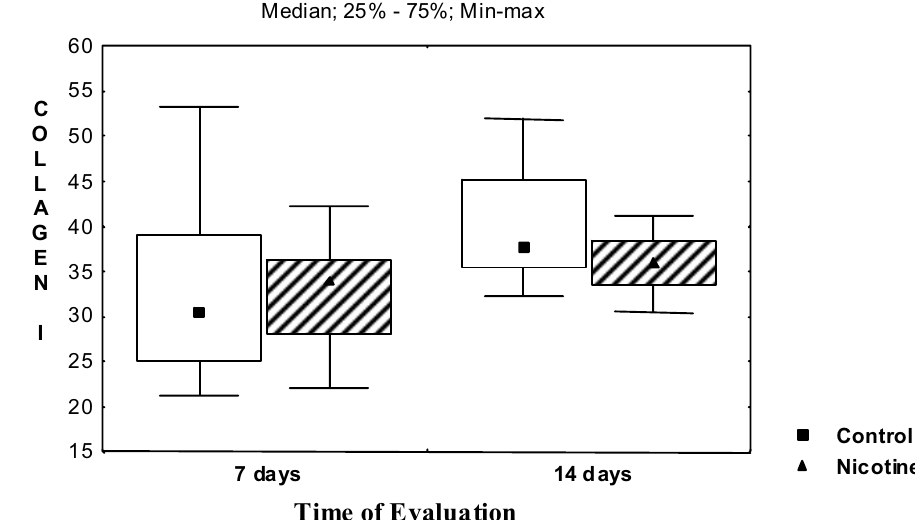
FIGURE 2 – Results of the collagen I evaluation, averages and standard